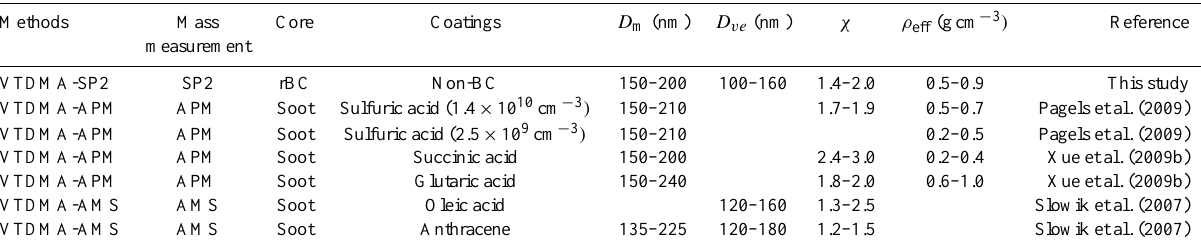
Table 2. Comparison of our method applied to atmospheric measurements and previous techniques used in laboratory measurements for determining the morphology and density of In-BC cores.